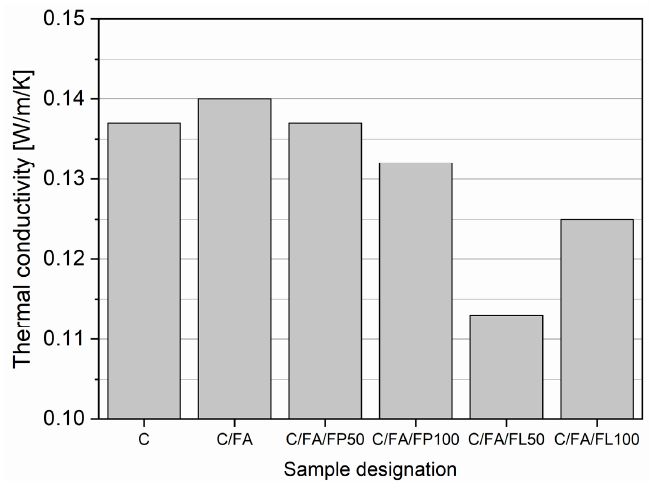
Figure 4. Thermal conductivity of foamed concrete mixes.